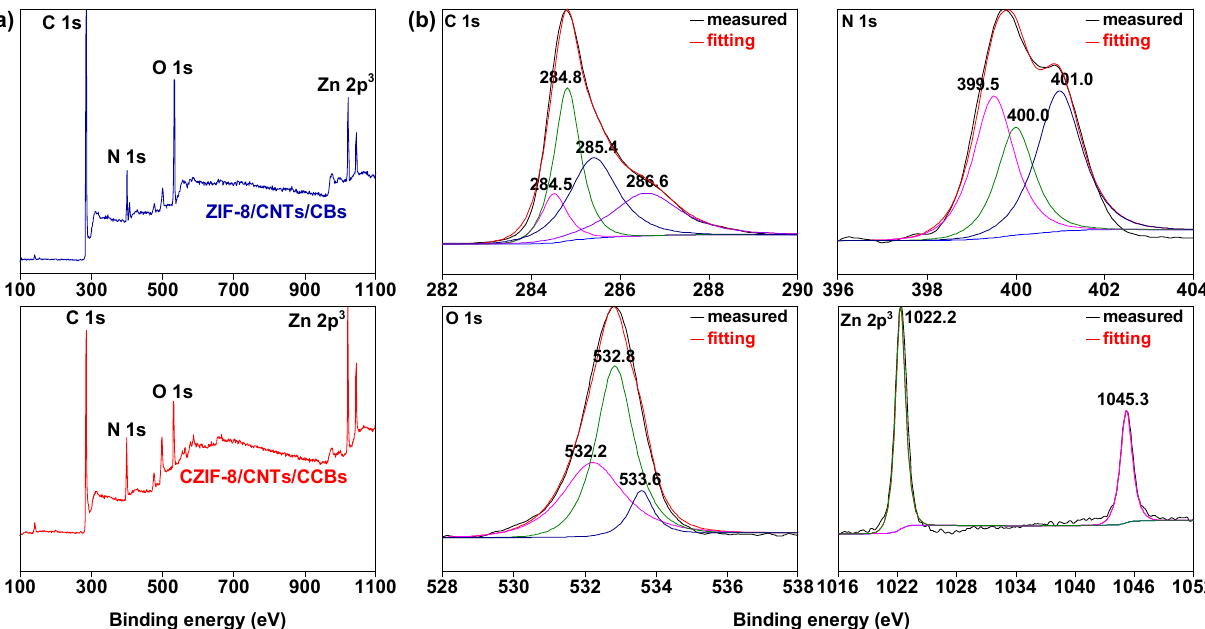
Figure 4. ( a ) XPS survey spectra of ZIF-8/CNTs/CBs and C ZIF-8/CNTs/CCBs. ( b ) C 1s, N 1s, O 1s, and Zn 2p 3 spectra of ZIF-8/CNTs/CBs.